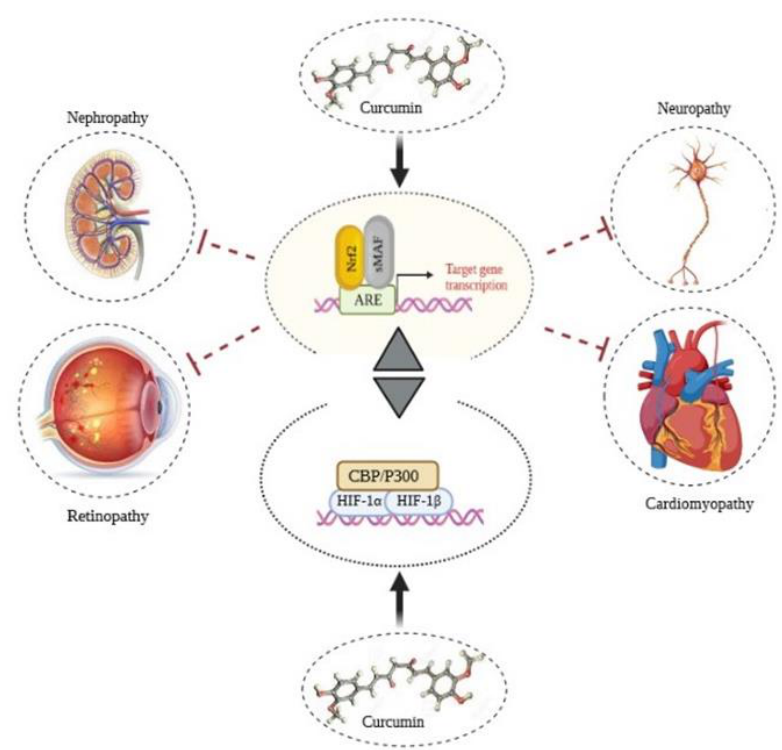
Figure 5. Anti-inflammatory effects of curcumin through modulation on Nrf2 and HIF1. Considering their correlation, modulation of Nrf2 and HIF-1 signaling pathways reduces diabetic complications by balancing ROS levels.